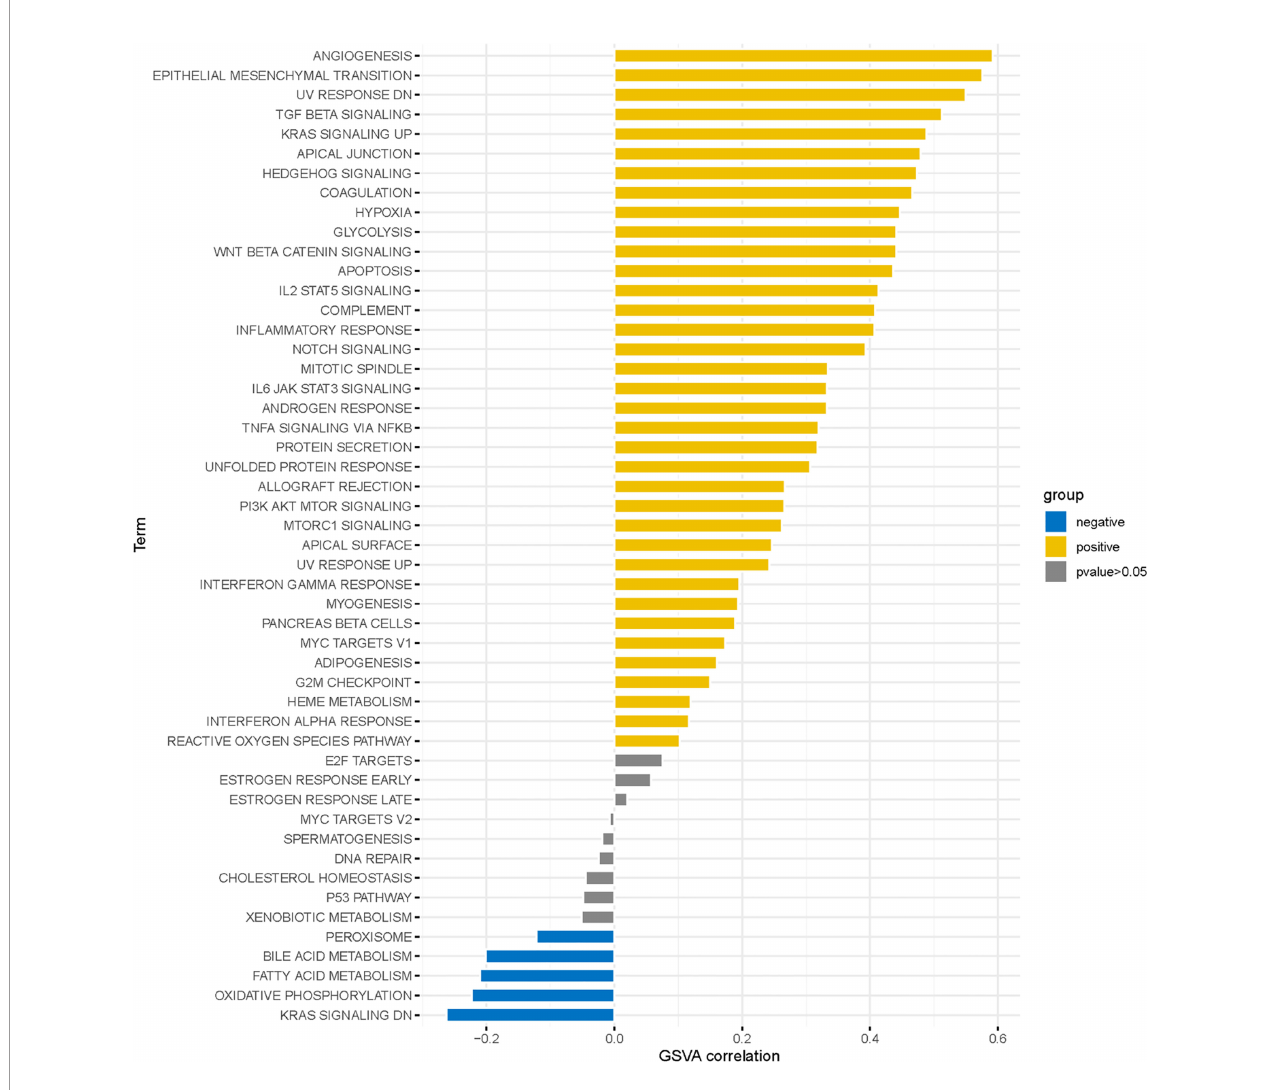
FIGURE 4 | GSVA enrichment analysis for